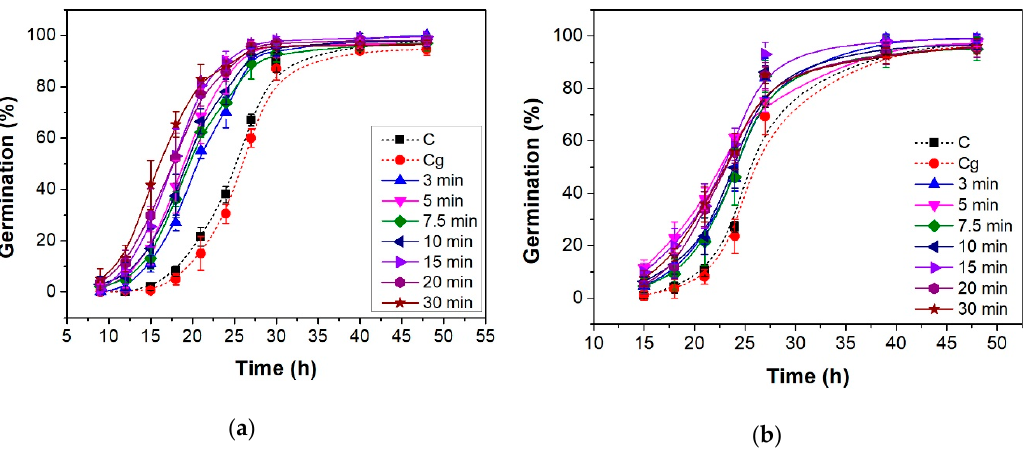
Figure 7. Germination acceleration of wheat seeds treated for different times (from 3 to 30 min) for both discharges ( a ) argon and ( b ) helium. Germination curves were fitted with the Hill function.